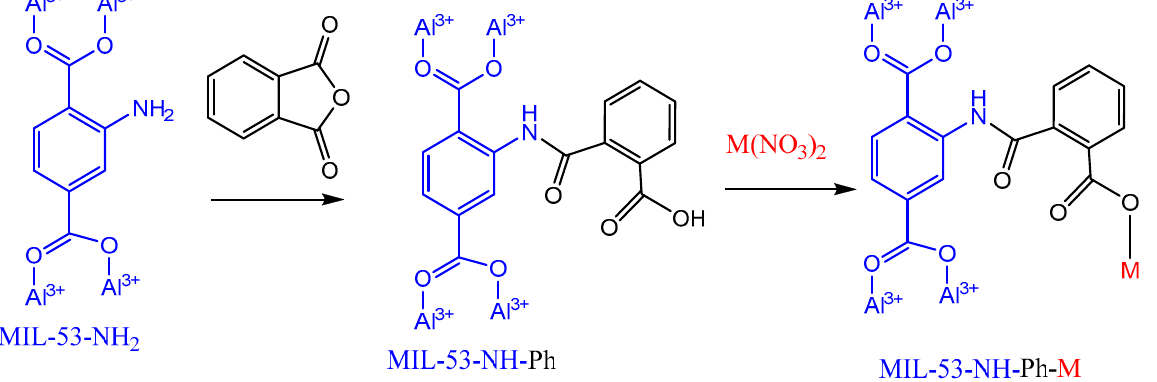
Figure 1. Post-synthetic modification of MIL-53-NH 2 with phthalic anhydride and its complexation with a transition metal.